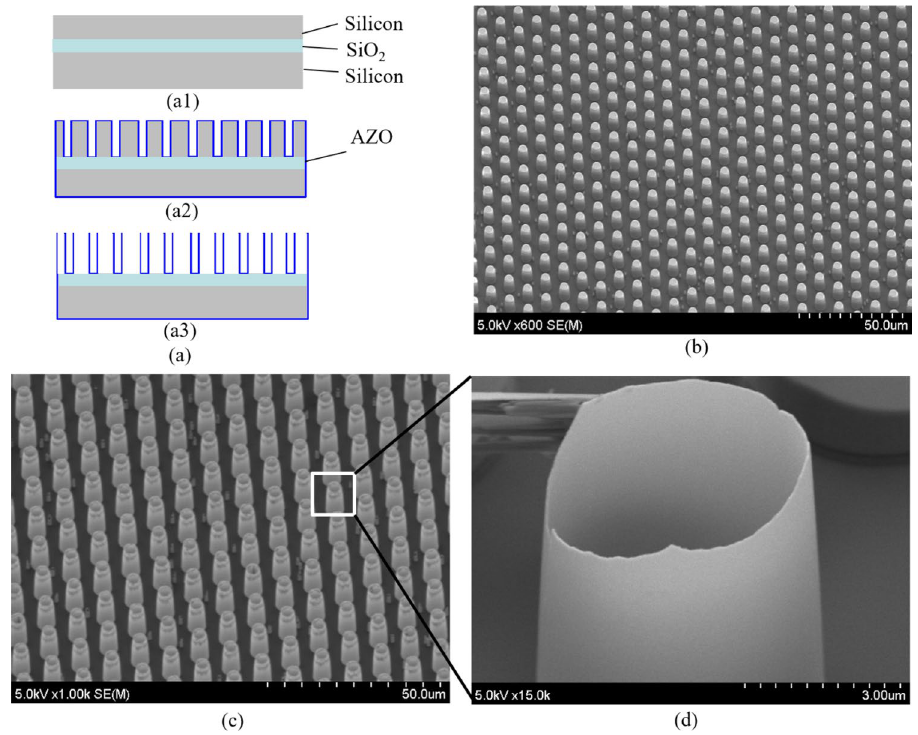
Figure 3. Micro-hollows with nanowall structure. ( a ) Fabrication process. ( a1 ) SOI wafer. ( a2 ) Deep RIE and ALD. ( a3 ) Silicon etching. ( b ) Micro-pillar silicon structures. ( c ) AZO hollows. ( d ) Close-up image of AZO hollow with nanowall